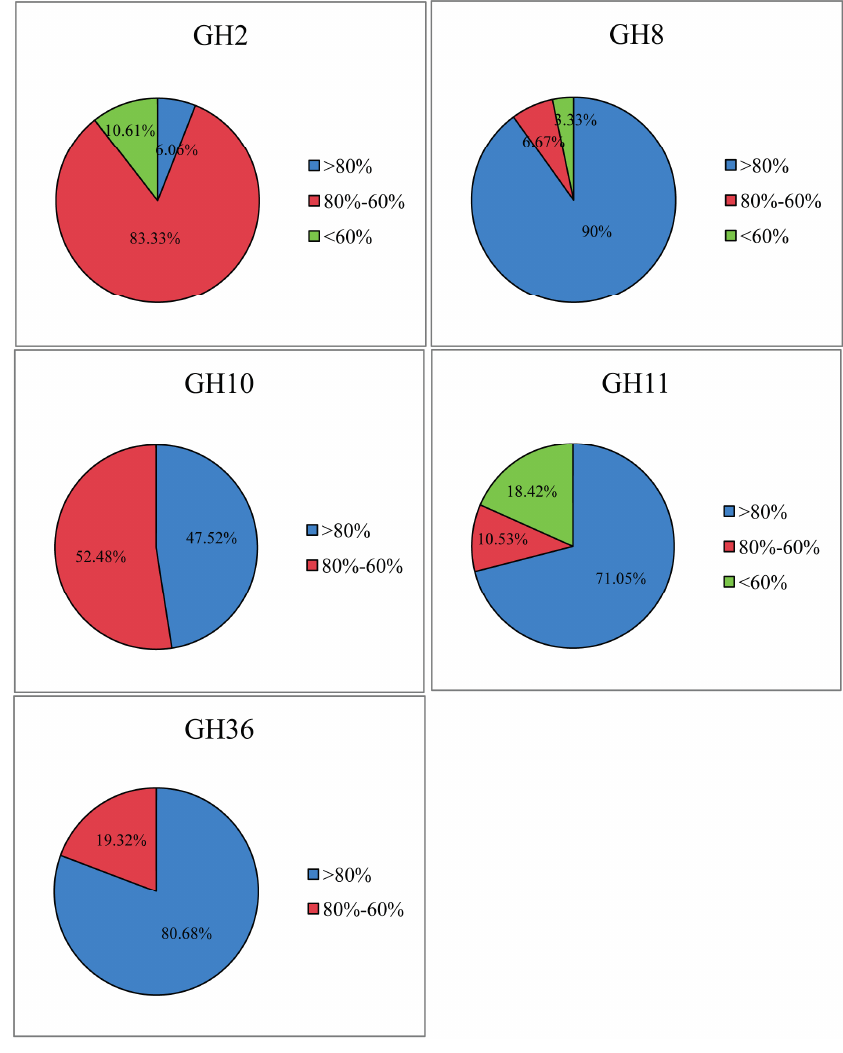
Figure 1. Amino acid sequence identities of cellulase and hemicellulase gene fragments to known enzymes. Each sequence was analyzed with NCBI BLASTp against the GenBank